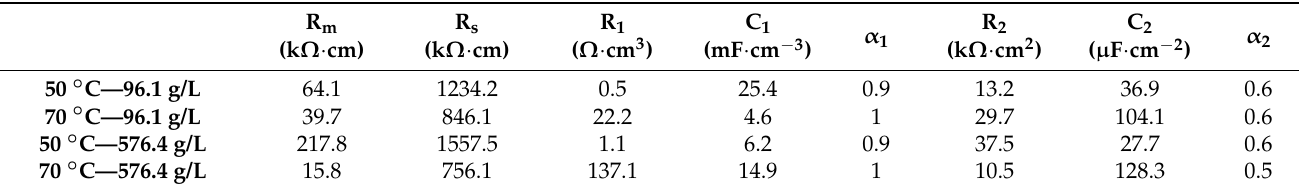
Table 10. Fitting parameters obtained from the impedance recorded in Na 2 SO 4 0.1 M for the phosphate coatings developed after the pickling in citric